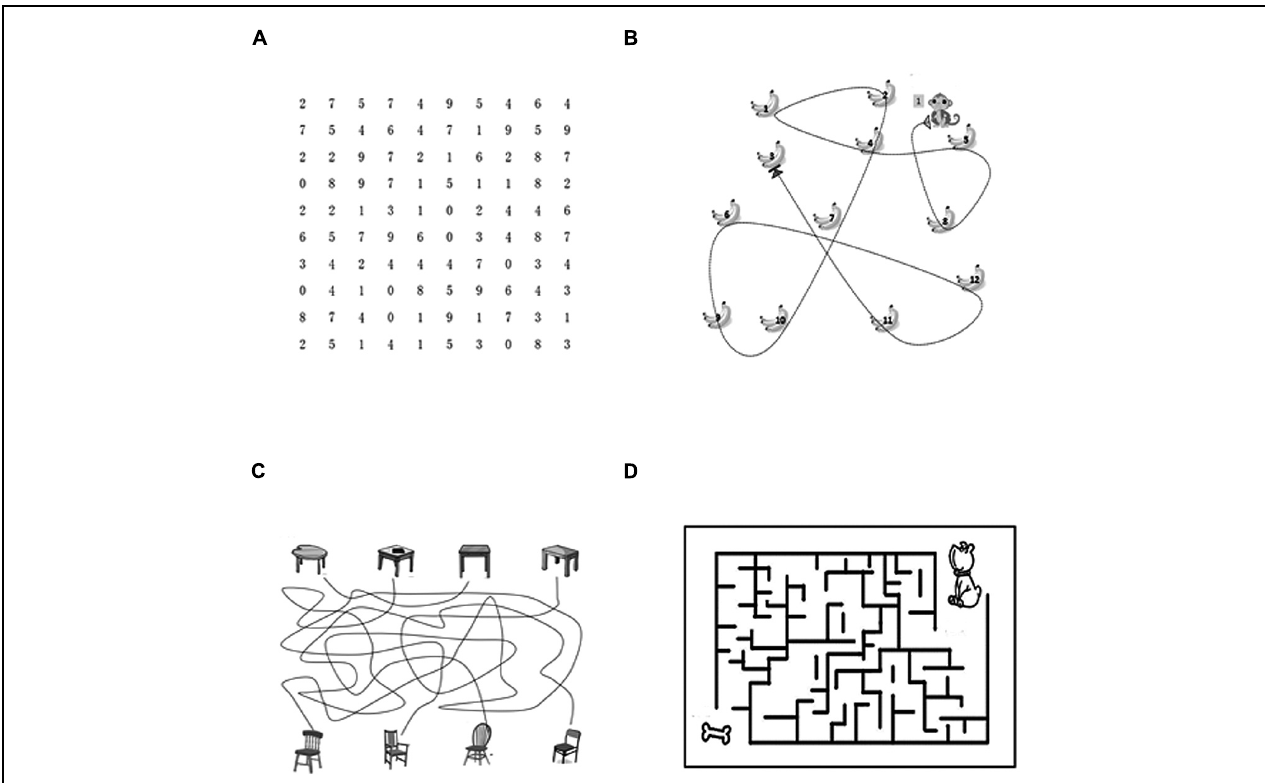
FIGURE 1 | The examples of visual search and visual tracking tasks. (A) The example of visual search; (B) The example of dynamic tracking; (C) The example of line puzzle (a task of static tracking); (D) The example of maze puzzle (a task of static